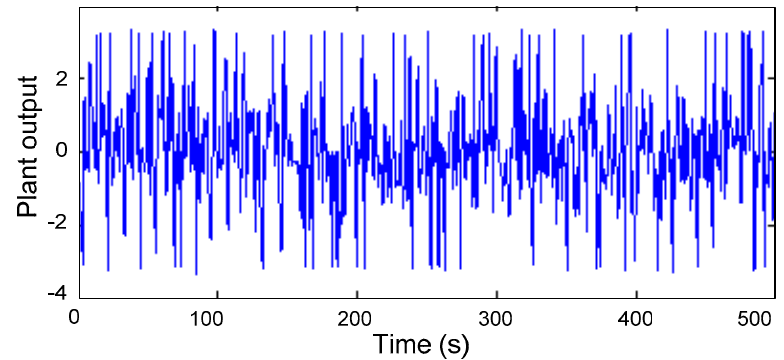
Figure 2. Plant input and output.